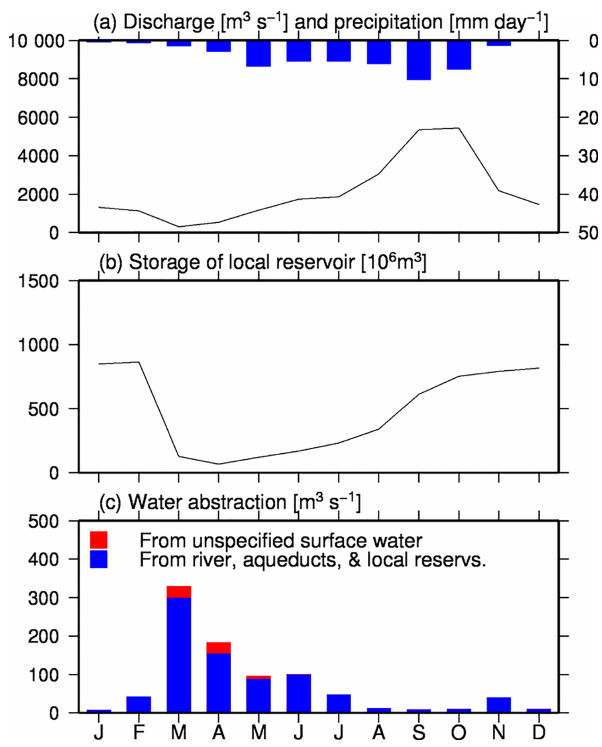
Figure 13. Hydrological conditions and water use in the grid cells near Bangkok, Thailand: (a) mean annual local monthly river dis- charge (m 3 s − 1 ) and precipitation (mmday − 1 ), (b) storage in local reservoirs, located in the upper stream (10 6 m 3 ), and (c) monthly water withdrawal (m 3 s − 1